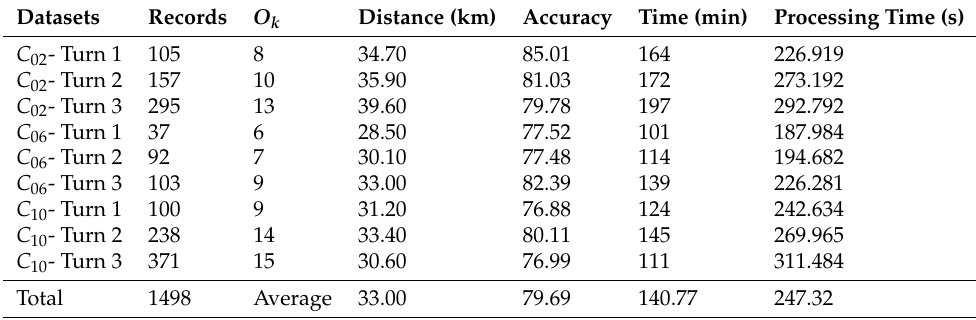
Table 4. Resultsin circuits C 02 , C 06 , y C 10 with data from the second semester of 2017.